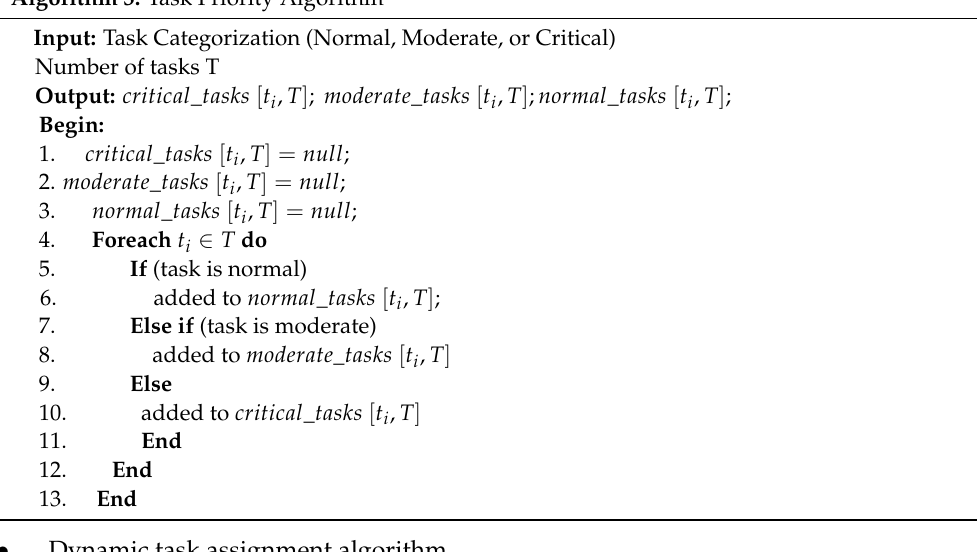
Algorithm 3. Task Priority Algorithm